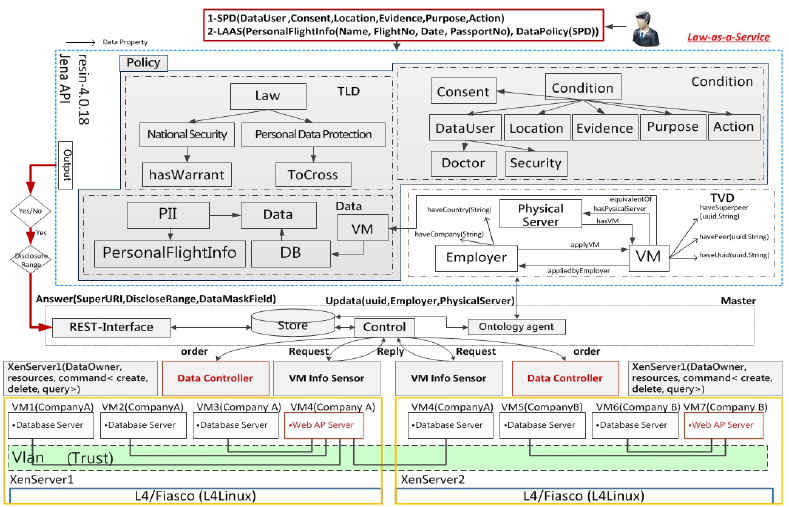
Figure 10. Semantic legal policies are expressed as logical theories of cq-programs, e.g., OWL-DL ontologies and stratified Datalog rules with negation, for information